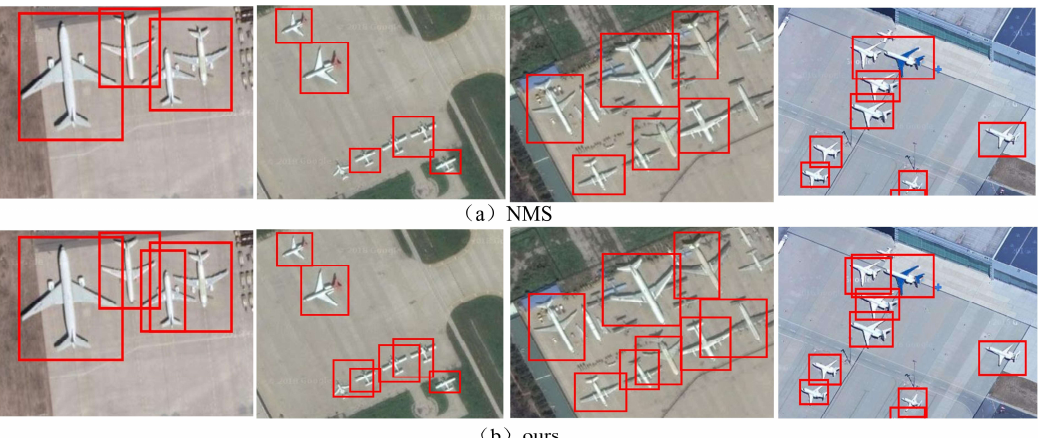
Figure 14. Airplane detection results. ( a ): results with traditional NMS; ( b ): results with improved